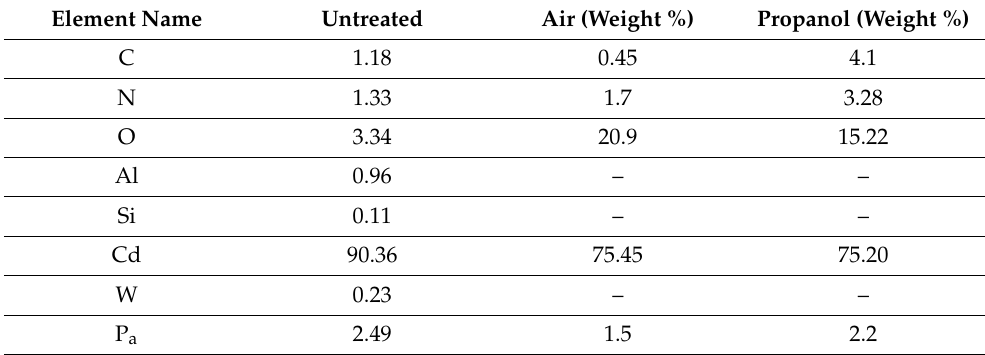
Table 5. EDS analysis of untreated and laser-ablated Cd for 500, 1000, 1500 and 2000 laser pulses, at constant fluence value of 3.6 J cm − 2 in air and propanol